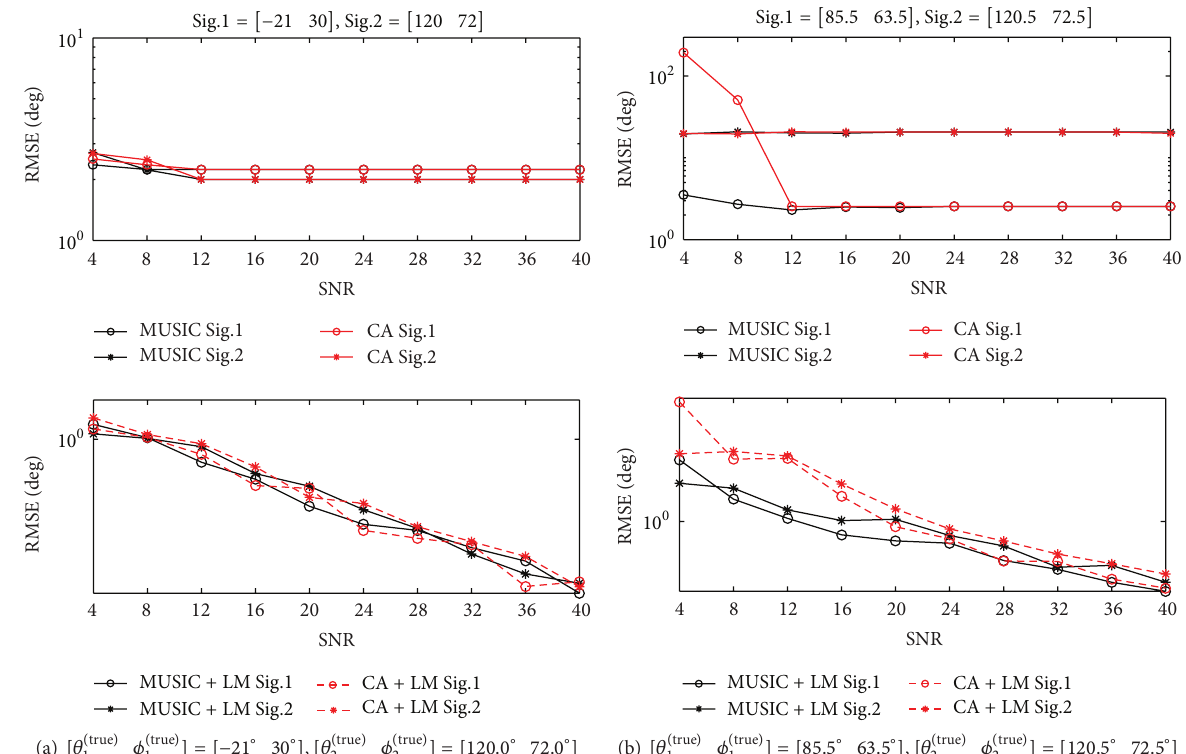
Figure 4: Comparison of the standard MUSIC algorithm and the standard Capon algorithm with fine exhaustive grid search and the MUSIC algorithm and the Capon algorithm with coarse exhaustive grid search followed by LM optimization ( 𝑟 = 0.679𝜆 , five antennas, [Δ𝜃 fine , Δ𝜙 fine ] = [4 ∘ ,4 ∘ ] , [Δ𝜃 coarse ,Δ𝜙 coarse ] = [7 ∘ , 7 ∘ ]